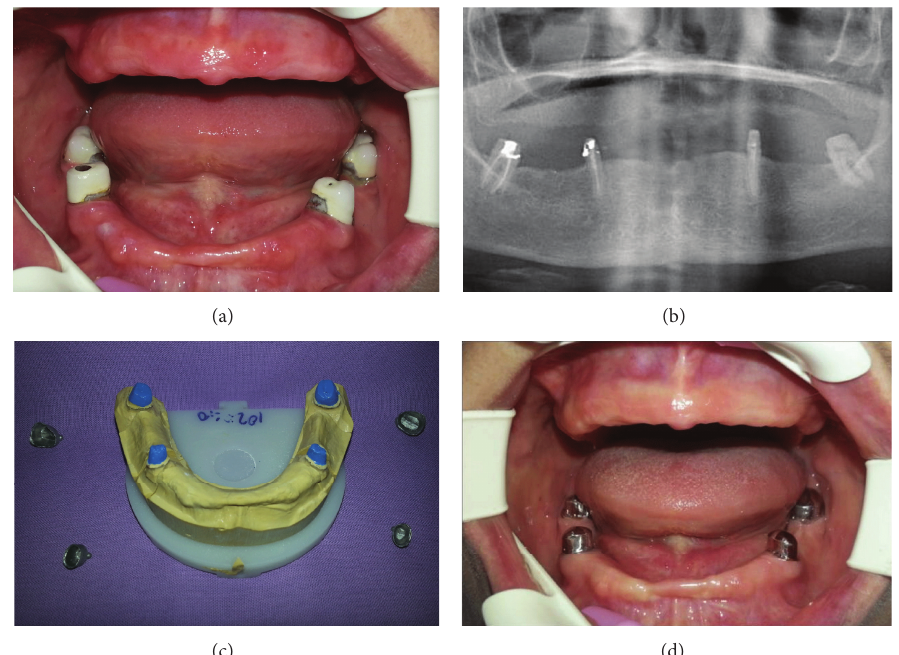
Figure 1: (a) Frontal and (b) orthopantomographic view of the case before treatment. The image of the primer copings on (c) cast model (d) and intraoral